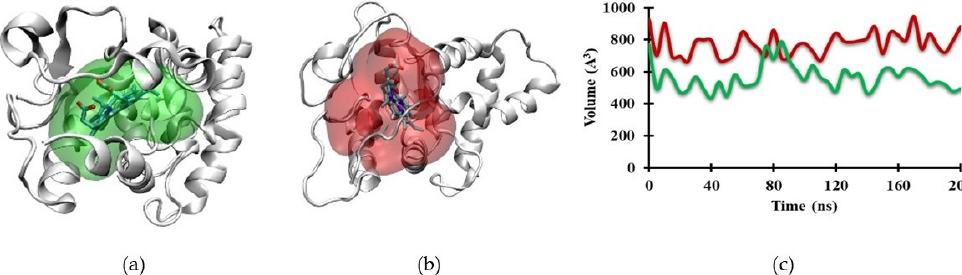
Figure 9. The cavity of ( a ) Heme and ( b ) CoPP on the Agonist-REV-ERB β binding pocket at the end of the simulation. ( c ) Plots of cavity values of Heme (green) and CoPP (red) in the binding site of Agonist-REV-ERB β during molecular dynam- ics simulations.